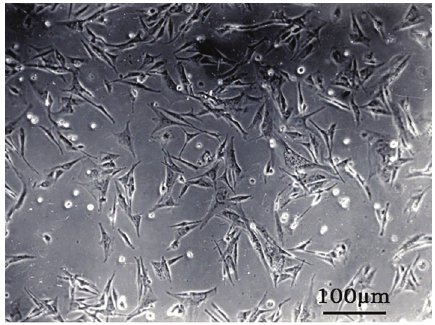
Figure 1. After seeding for 24 h, passage 3 fi broblasts adhered and stretched. Phase contrast microscope, (cid:1) 100.